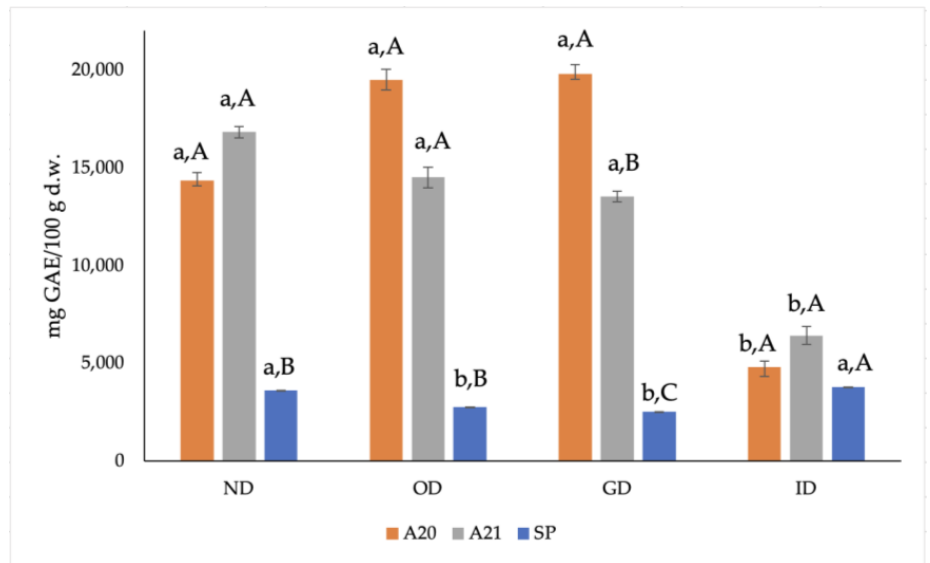
Figure 1. Effect of in vitro digestion on the phenolic content (expressed as mg GAE/100 g d.w.) of the three phenolic extracts. ND: non-digested; OD: oral digestion; GD: gastric digestion; ID: intestinal digestion; SP, spray-dried. Values are means of triplicates ± standard deviation (SD); a,b, statistically different means during digestion ( p ≤ 0.05); A–C, statistically different means among samples ( p ≤ 0.05).